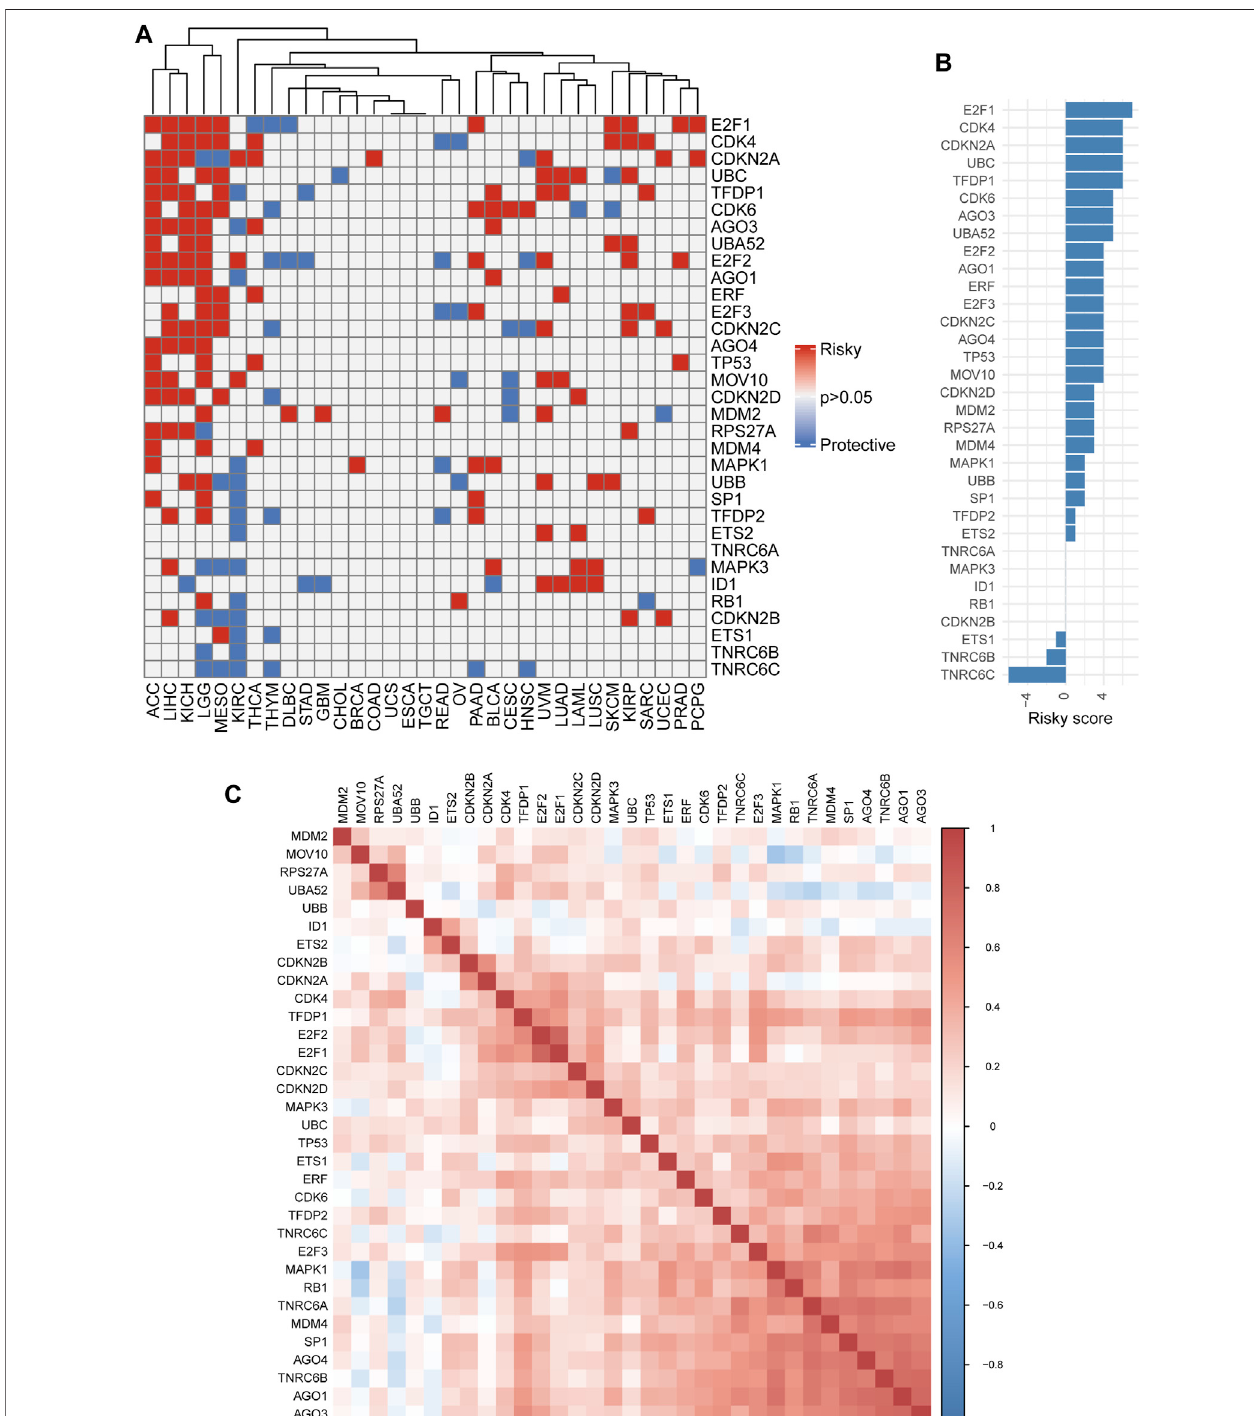
FIGURE 4 | Single nucleotide variation (Survival analysis of senescence-related genes (SRGs). (A) Heatmap showing univariate Cox regression analysis of SRGs ( p > 0.05: all gray; p < 0.05: hazard ratio (HR) > 1 indicates red and HR < 1 indicates blue). (B) The summary statistics for Cox regression analysis of all 33 senescence genes across 33 tumors. Senescence genes were sorted by descending number of a risky score (for risk factor, +1; for protective factor, − 1). (C) The correlation plot determined with the Spearman correlation test results show the correlation of gene expression among SRGs across 33 cancer types. A positive correlation is indicated inred, and anegative correlationisdenoted in blue. Adarkercolor indicates stronger correlations(Spearman correlation, p < 0.05 wasconsidered signi fi cant).